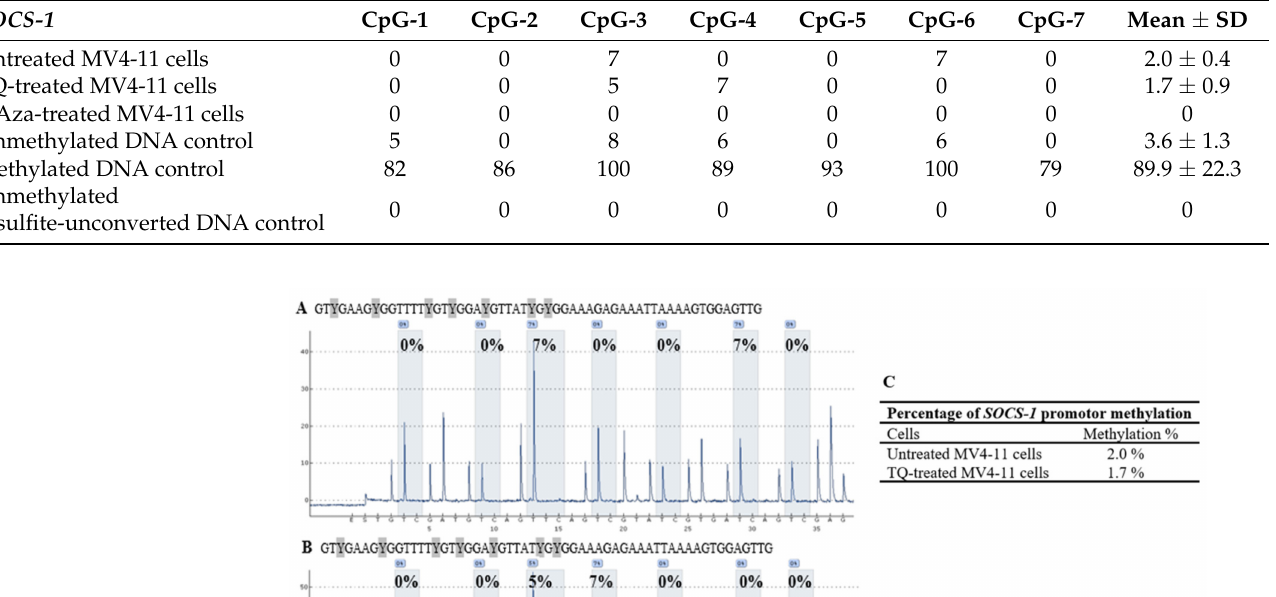
Table 3. Percentages of methylation of CpG islands in the promoter region of SOCS-1 gene.